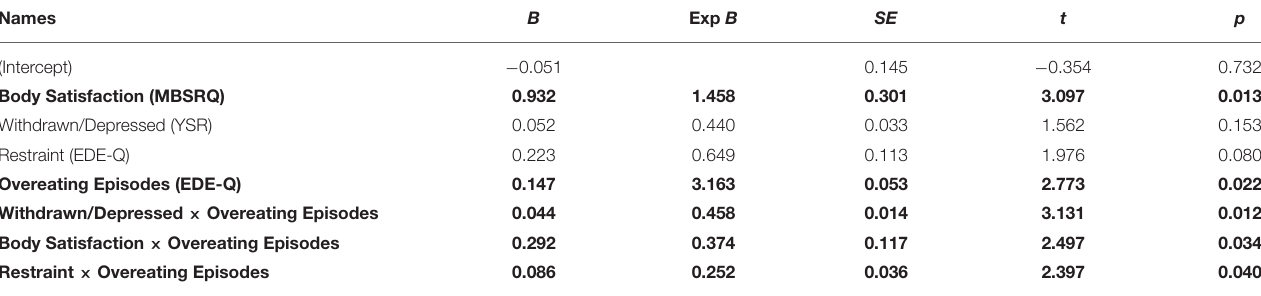
TABLE 3 | Multivariate linear regression model indicating predictors of weight loss (BMI SDS Change).